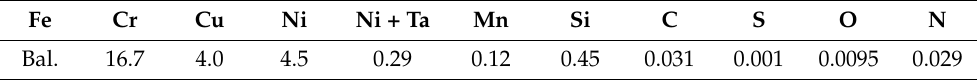
Table 1. Chemical composition (wt.%) of the considered 17-4 PH stainless